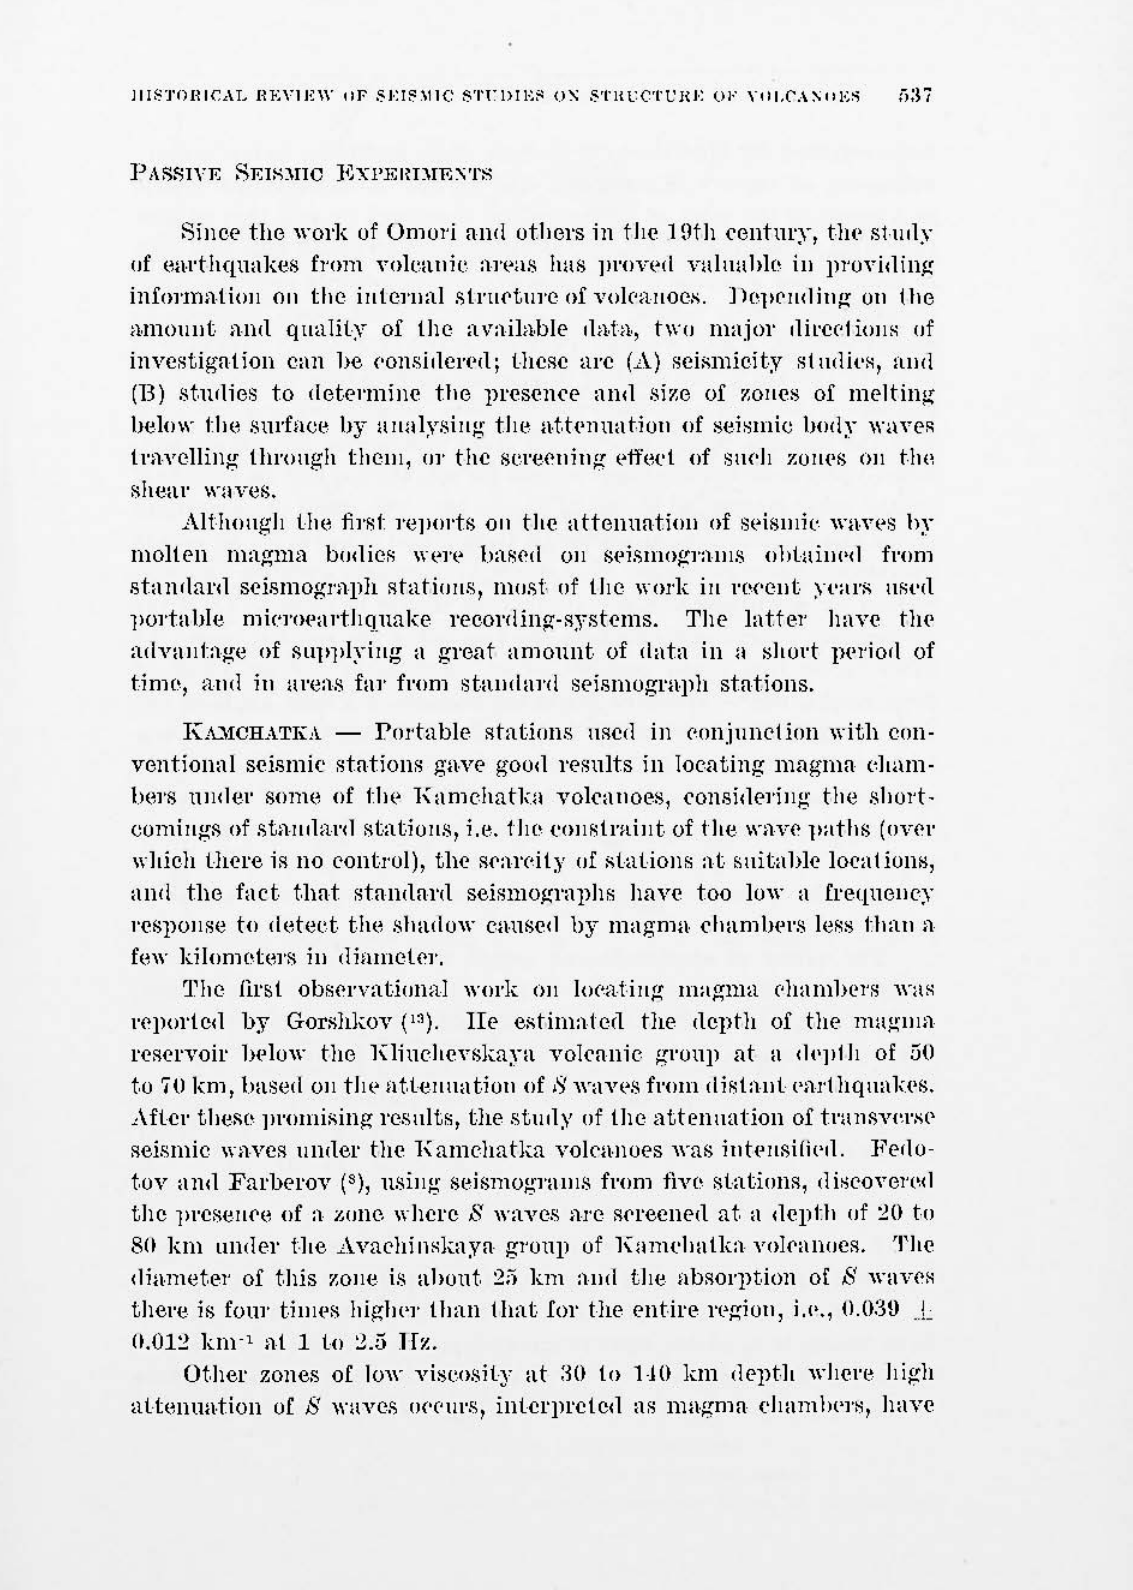
POl'table stations nscd in ('onjllnclion with